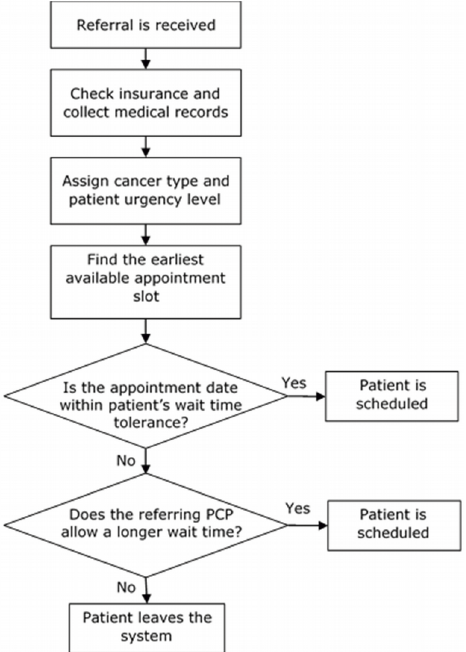
Figure 1. New patient appointment scheduling process